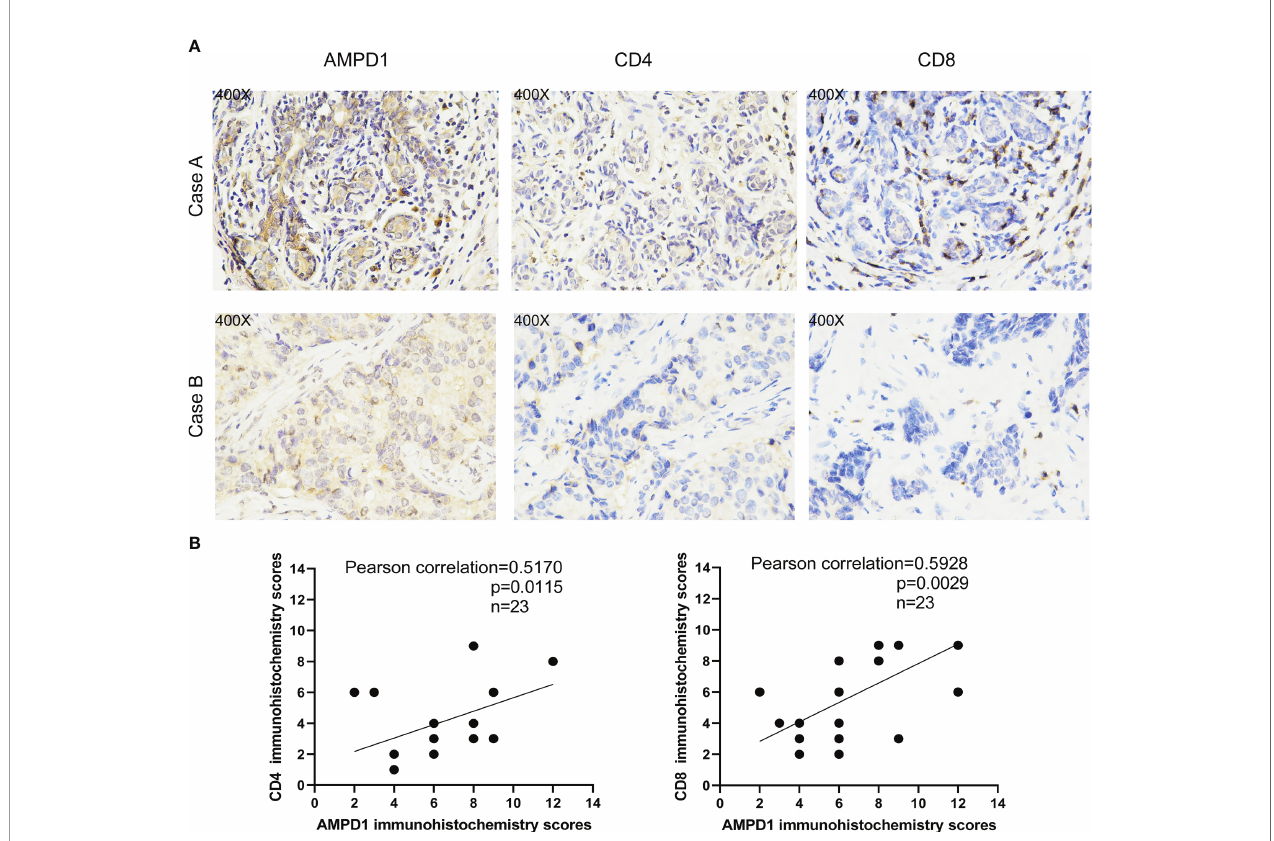
FIGURE 8 | AMPD1 expression is positively correlated with CD4 and CD8 in HER2+ BC tissues. (A) Representative images of AMPD1, CD4 and CD8 staining. Case A: High expression of AMPD1, CD4 and CD8; Case B: Low expression of AMPD1, CD4 and CD8. (B) The correlations between AMPD1, CD4 and CD8 expression were analyzed by Pearson correlation